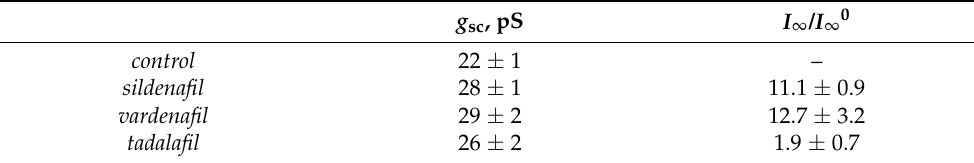
Table 3. The effect of the PDE-5 inhibitors on the pore-forming activity of GrA and Nys. The lipid bilayers were composed of POPC (GrA) and POPC/Chol (67/33 mol%) (Nys) and bathed in 2.0 M KCl, pH